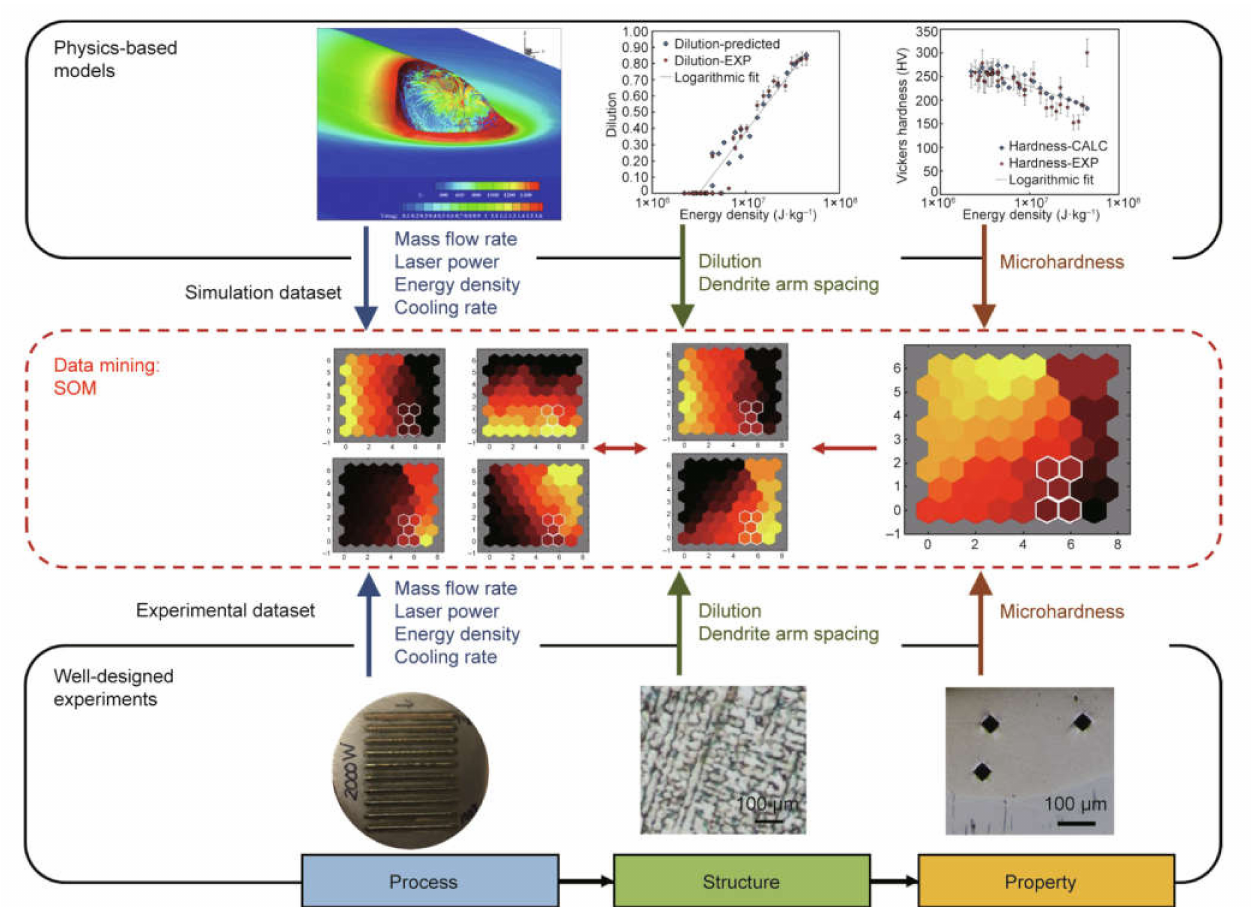
Figure 13. An illustration of the workflow normally used in current numerical studies ( top row ) and experimental studies ( bottom row ), accompanied by a description of how the ANN technique can be incorporated to discover useful process– structure–property relationships of certain materials [93]; published under the open access Creative Commons license with